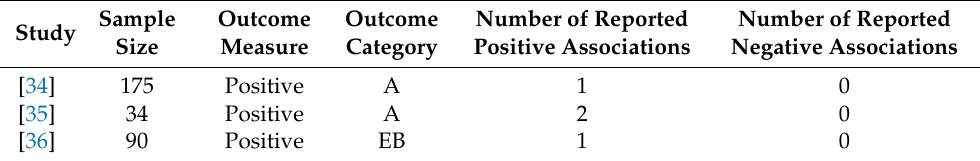
Table 4. Free play—outcome measure descriptions and results summary. Sample Study